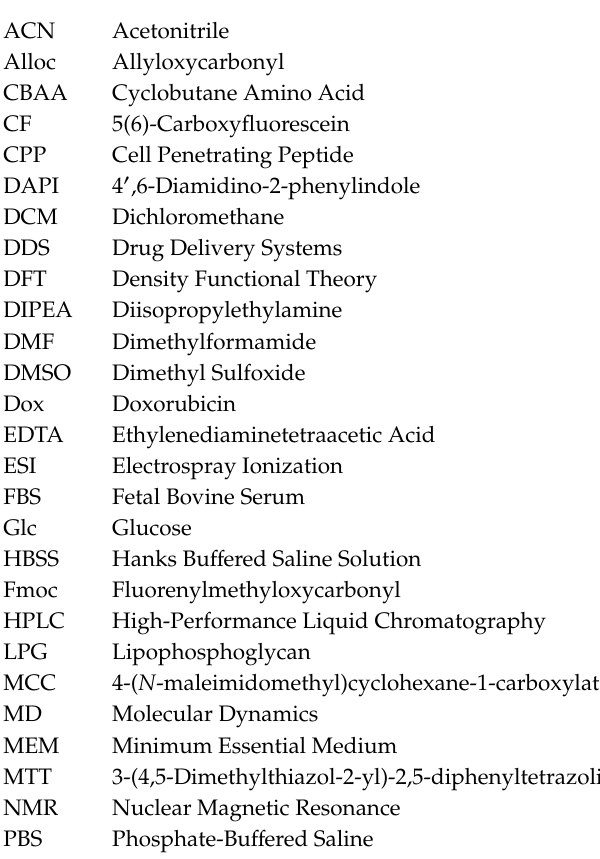
Figure S8: a) Hairpin conformation, and b) hydrogen bonding pattern as predicted by MD simulations for CF-CC 7 ; Figure S9: a) Laminar conformation, and b) and c) hydrogen bonding pattern as predicted by MD simulations